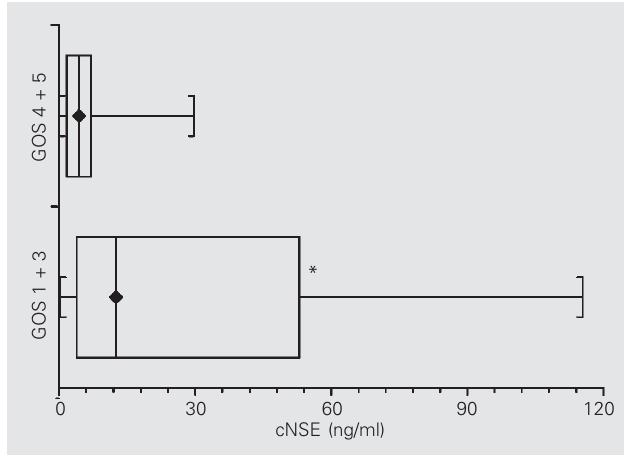
Figure 4. Distribution of neuron-specific enolase levels in cerebrospinal fluid (cNSE) of subjects with scores 1 + 3 (N = 7) on the Glasgow Outcome Scale (GOS) and of subjects with scores 4 + 5 on the GOS. *P = 0.035 compared to GOS 4 + 5 (N = 44) (Mann-Whitney test).